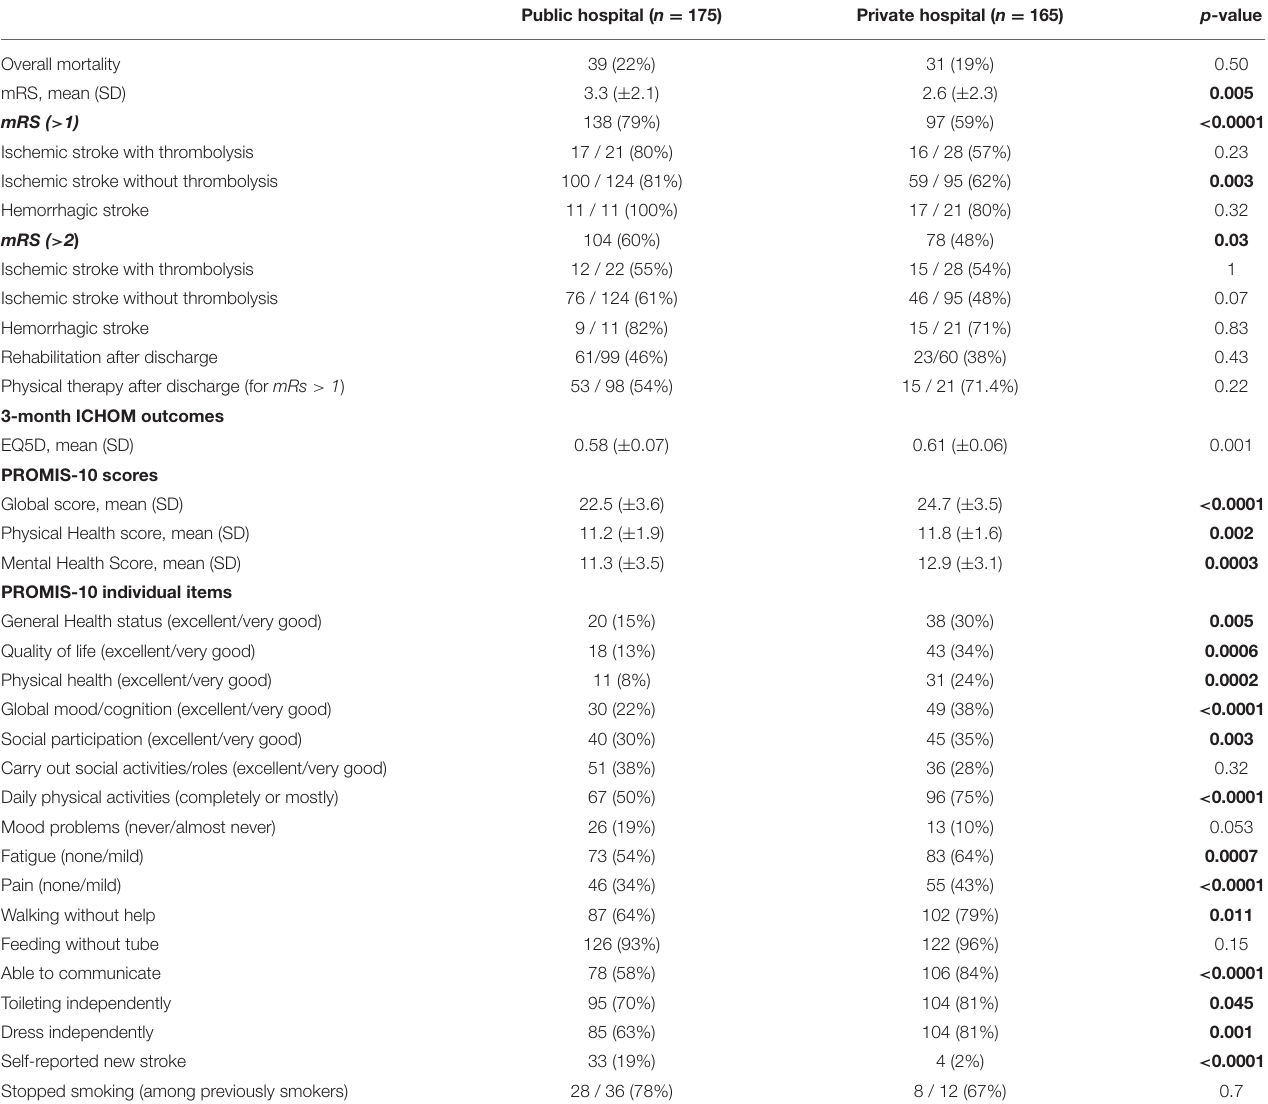
TABLE 2 | 3-month outcome measurement accord to private and public